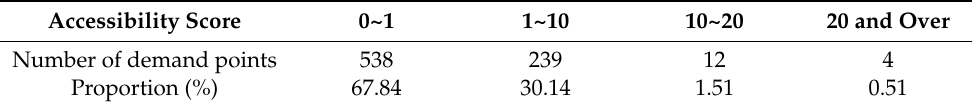
Table 5. Accessibility scores of different demand